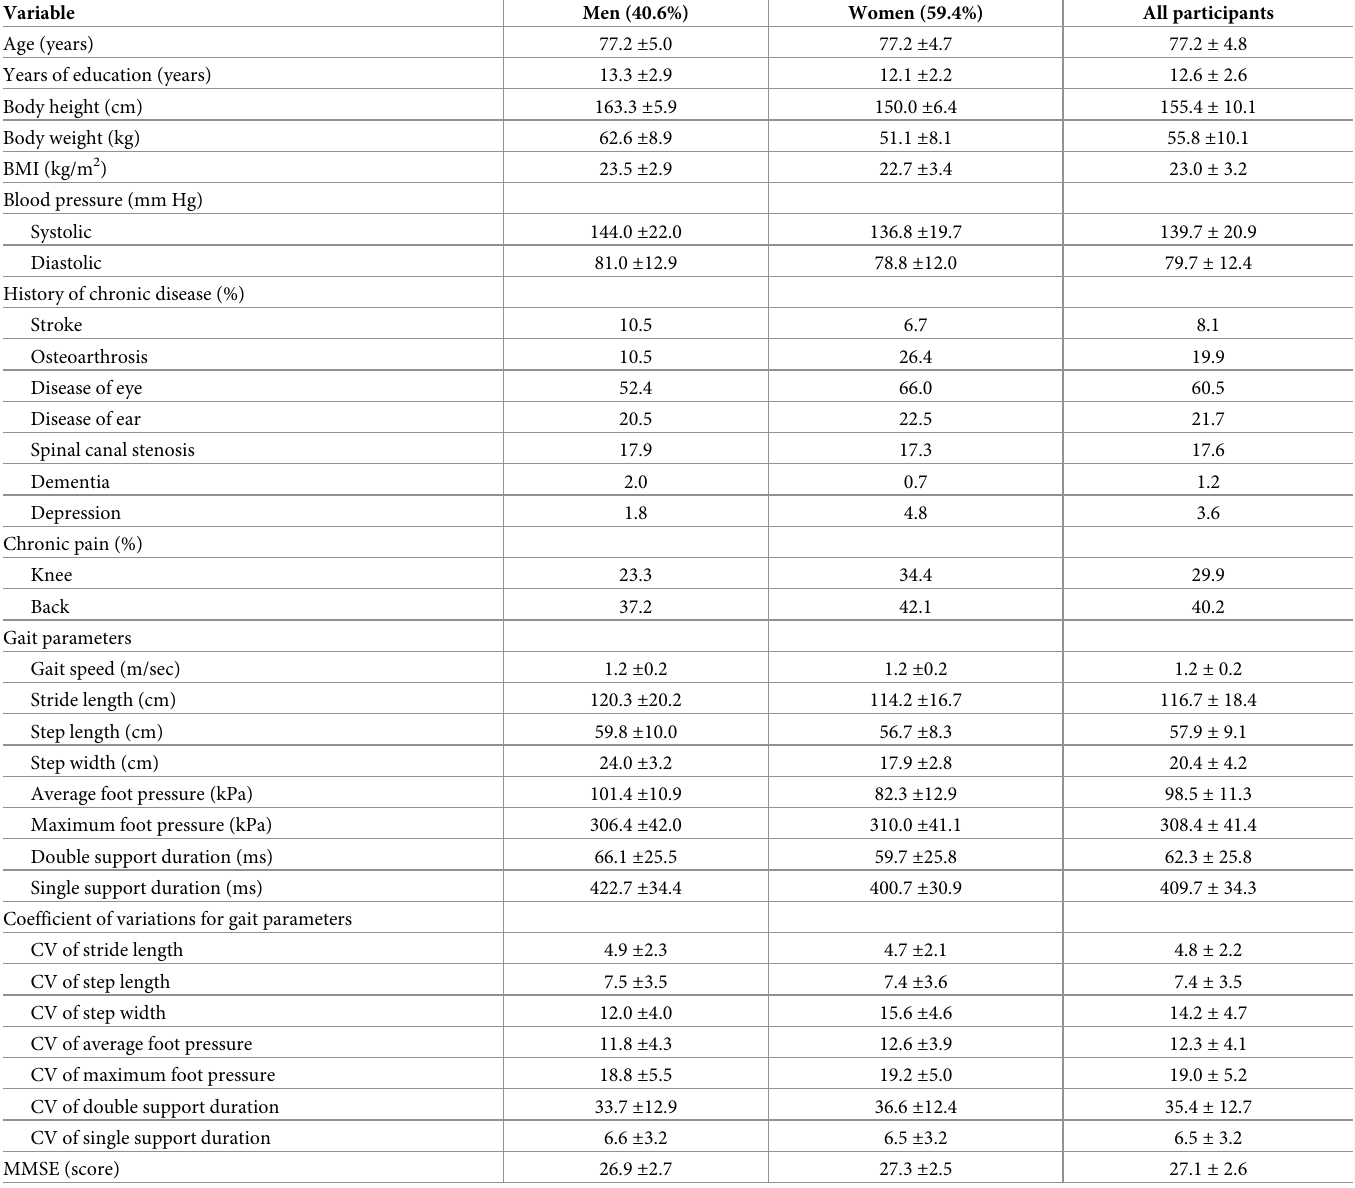
Table 1. Baseline demographic and health characteristics of 1240 community-dwelling older adults.